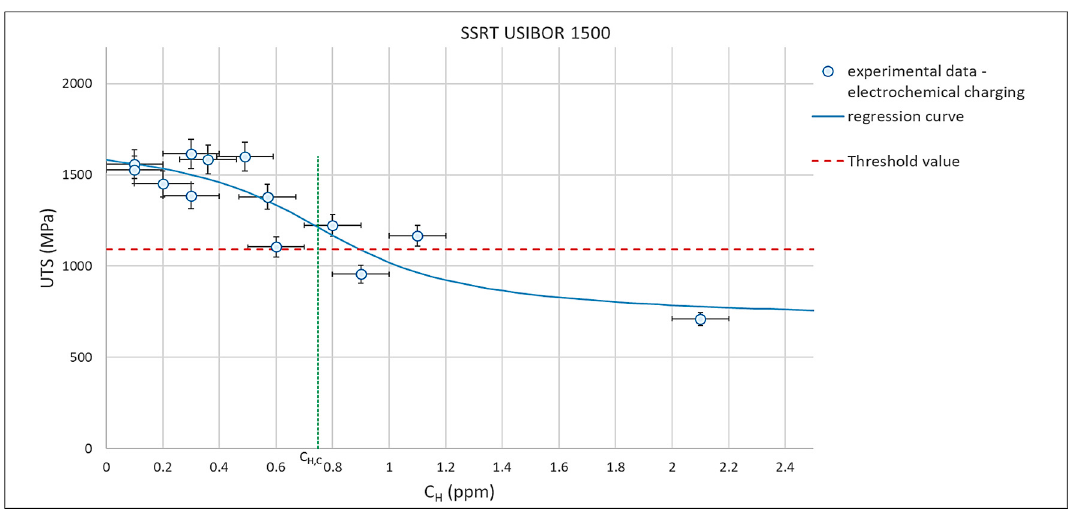
Figure 6. SSRT for USIBOR 1500 ®